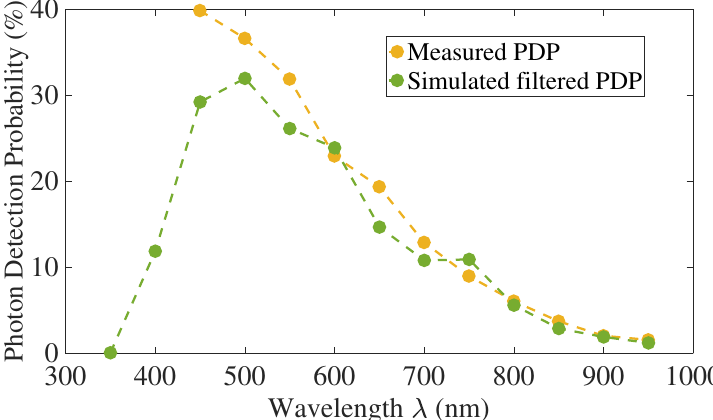
Figure 13. Photon Detection Probability for V Ex = 20% V Br , without substrate